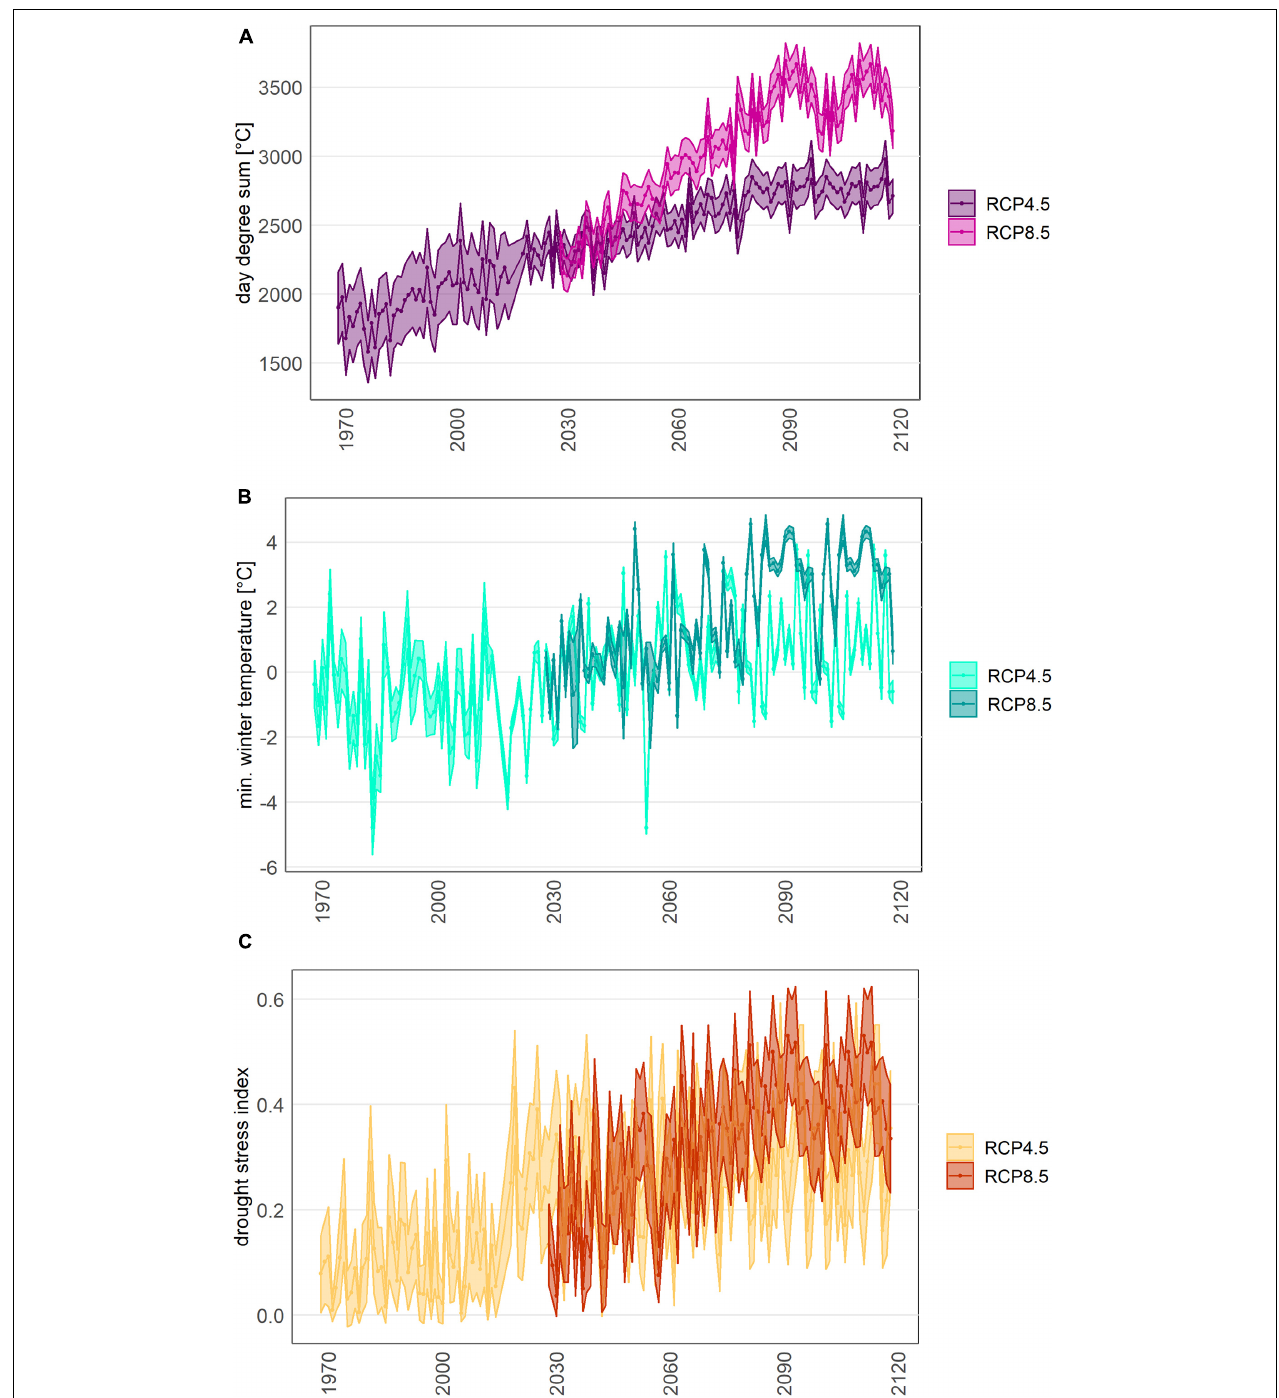
FIGURE 2 | Bioclimatic variables used for the TreeMig simulations: day degree sum (A) , mean minimum winter temperature (B) , and drought stress index (C) from 1970 to the beginning of the stabilizing period (2120). The spin up of the simulations run from 1616 to 2016, with climate data sampled from interpolated measured data from 1930 to